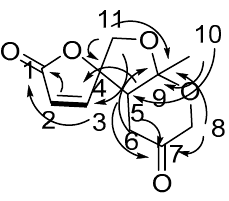
Figure 3. COSY correlations and HMBC correlations of chaetoginsin ( 3 ).